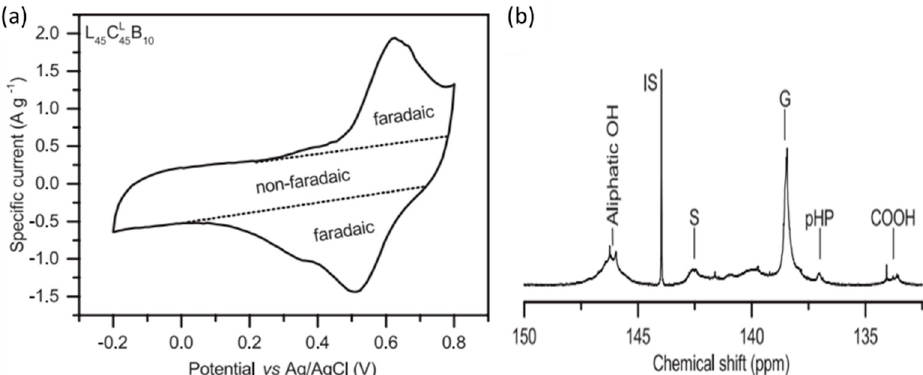
Figure 2. ( a ) CV trace (recorded at 5 mV s − 1 ) of a lignin composite electrode in 1 M HClO 4 , with the contributions made by the Faradaic and non-Faradaic processes to the charge storage. ( b ) The 31P NMR spectrum of phosphorylated lignin, featuring signals for aliphatic OH groups; the internal standard (IS); the S, G, and p-hydroxyphenyl (pHP) groups; and COOH groups. Reprinted with permission from Ref. [27]. Copyright 2017 John Wiley & Sons.